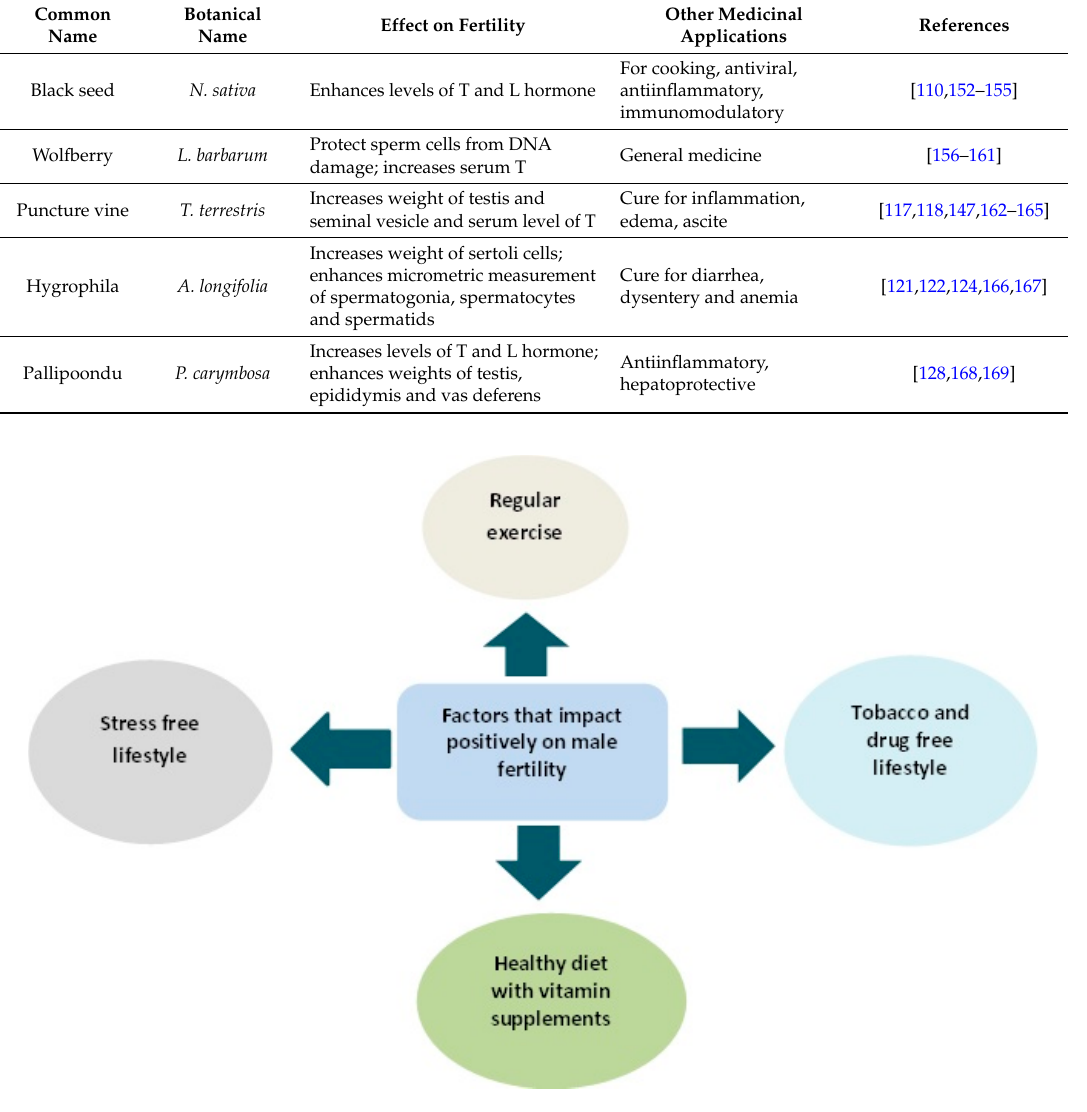
Figure 14. Fertility boosting lifestyle.